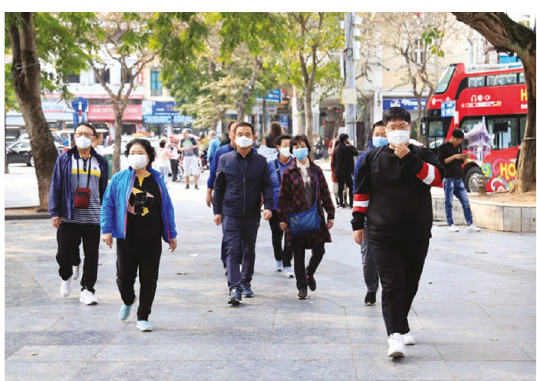
Figure 19: Vietnamese people often use medical masks (source from the